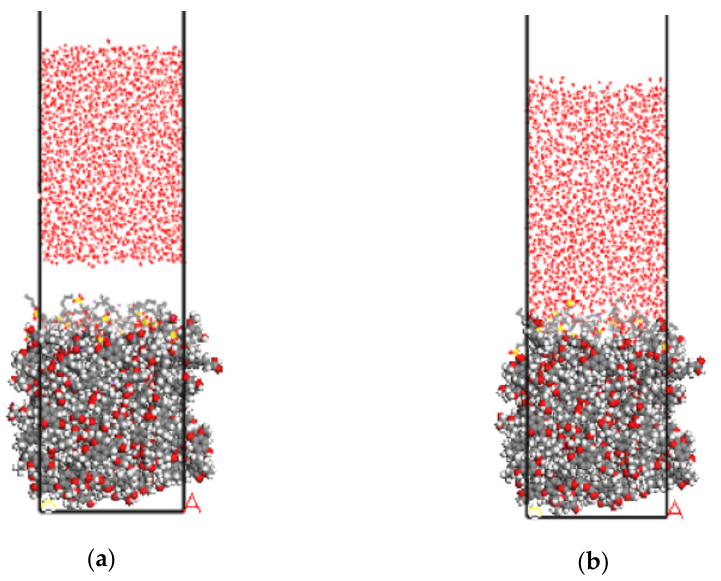
Figure 7. The initial ( a ) and equilibrium ( b ) configurations of the water-S2-lignite system.